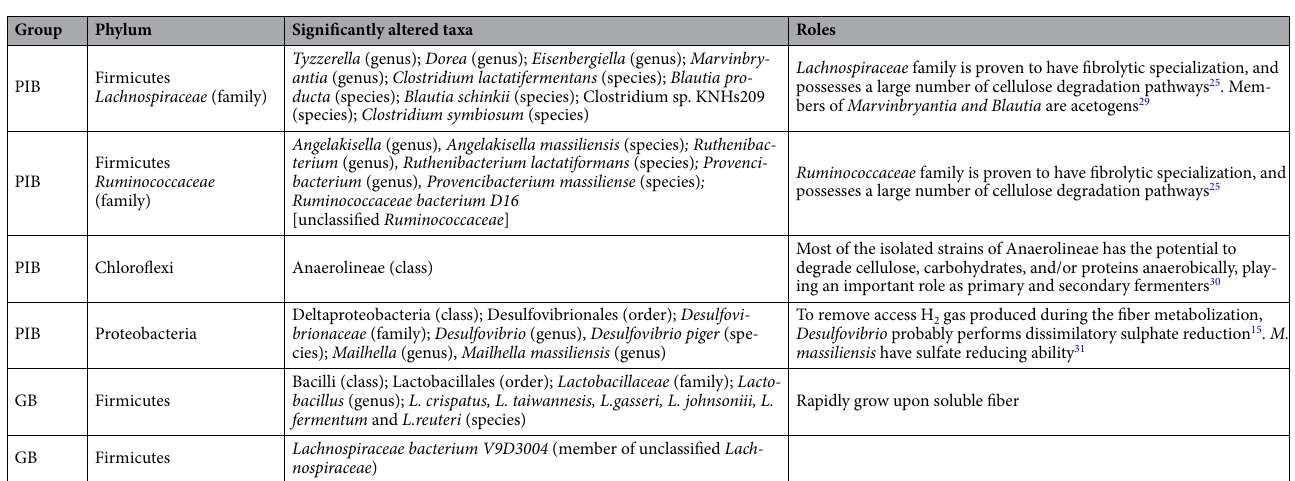
Figure 3. Extended error bar plot showing the differentially abundant taxa at all taxonomic levels, namely, ( A ) phylum, ( B ) class, ( C ) order ( D ) family, ( E ) genus, and ( F ) species.